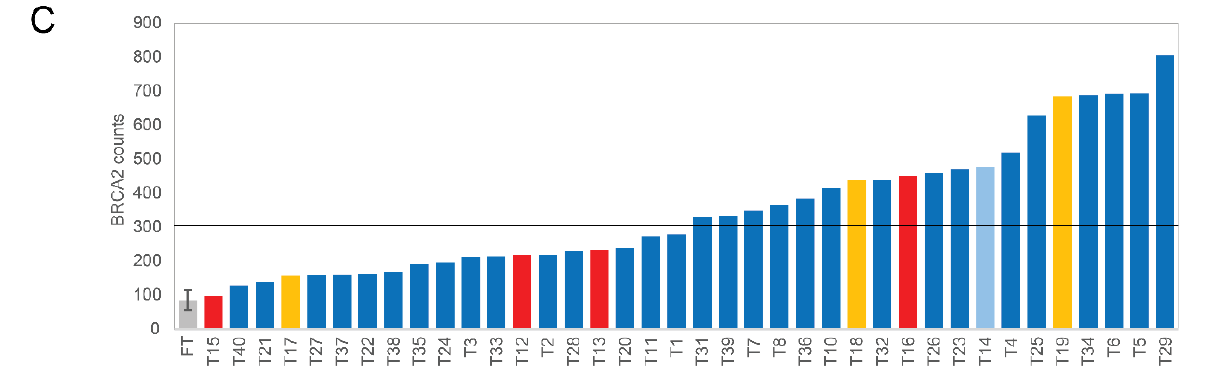
Figure 1. Expression level of BRCA1 and BRCA2 genes in 11 normal fallopian tubes and 38 tumor samples analyzed with the NanoString nCounter assay. Tumor samples showed both higher median expression levels as well as greater variability. ( A ) NanoString counts for BRCA1 and BRCA2 , in both fallopian tube and tumor samples. The horizontal bar marks the median. ( B , C ) Individual mRNA counts for each tumor (T) are shown ordered from lowest to highest BRCA1 ( B ) and BRCA2 ( C ) expression levels. Tumors with identified mutations are highlighted (red, frameshift mutations; yellow, Portuguese BRCA2 founder mutation; light blue, missense mutations). For the 11 normal fallopian tube (FT) samples, the mean and standard deviation are depicted.